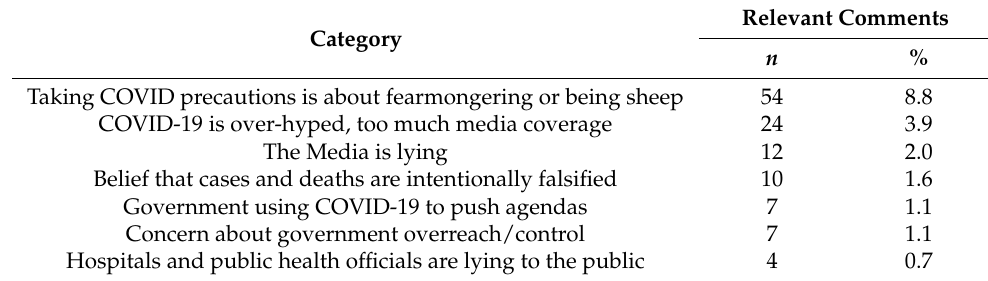
Table 3. Themes related to